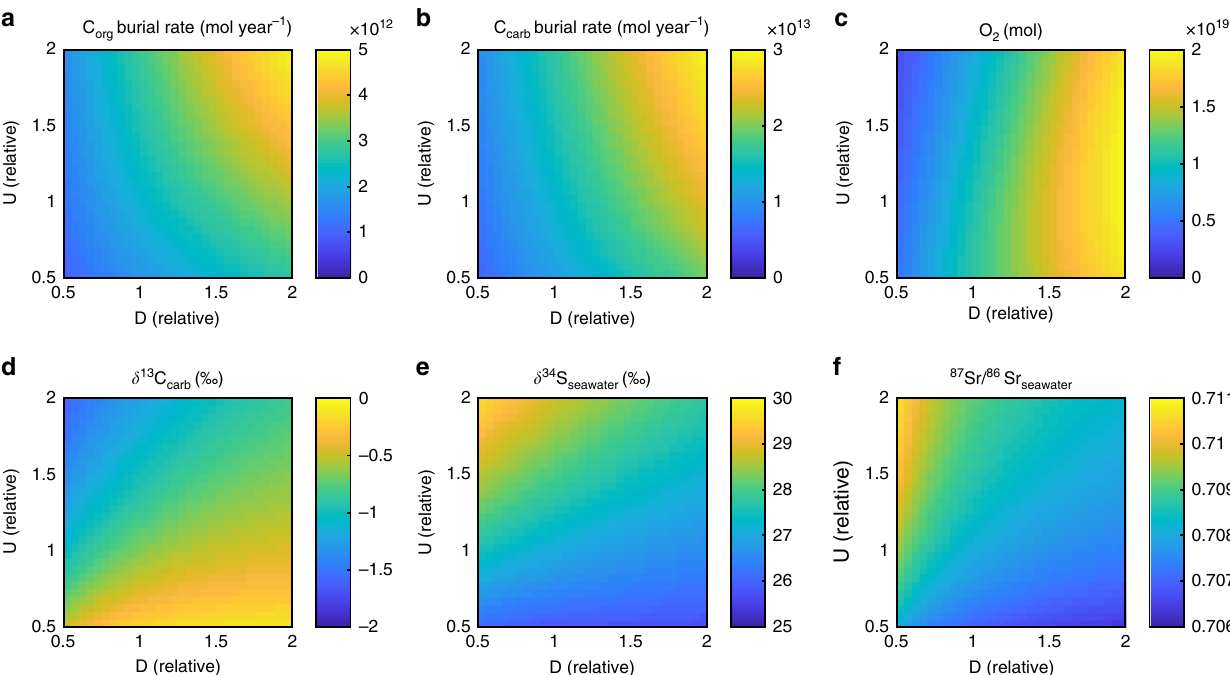
Fig. 4 Steady states of the COPSE model with respect to changing degassing inputs (D) and global uplift/erosion rate (U). a Organic carbon burial rate. b Carbonate burial rate. c Atmosphere and ocean oxygen reservoir. d Ocean δ 13 C carb . e Ocean δ 34 S. f Ocean 87 Sr/ 86 Sr. All model forcings are held constant at 541 Ma, with the model allowed to stabilise for 10